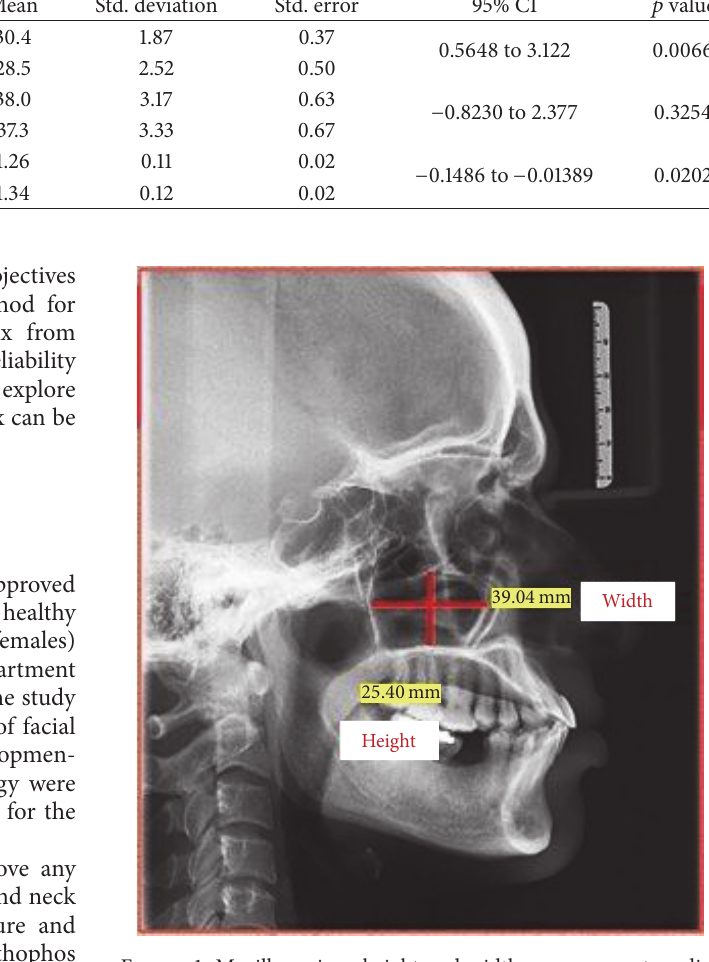
Figure 1: Maxillary sinus height and width measurements radio- graphically using Sidexis next generation